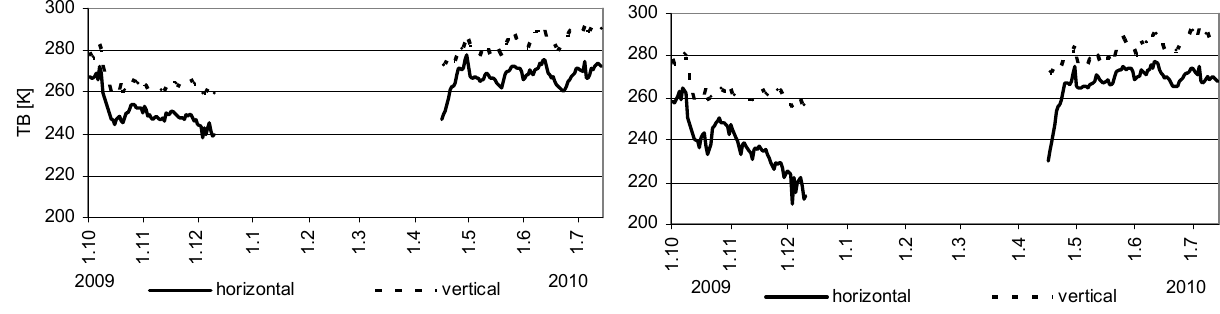
Figure 7. Measured ELBARA brightness temperatures (TB) for angle 50° (left) and 65° (right) for both vertical and horizontal